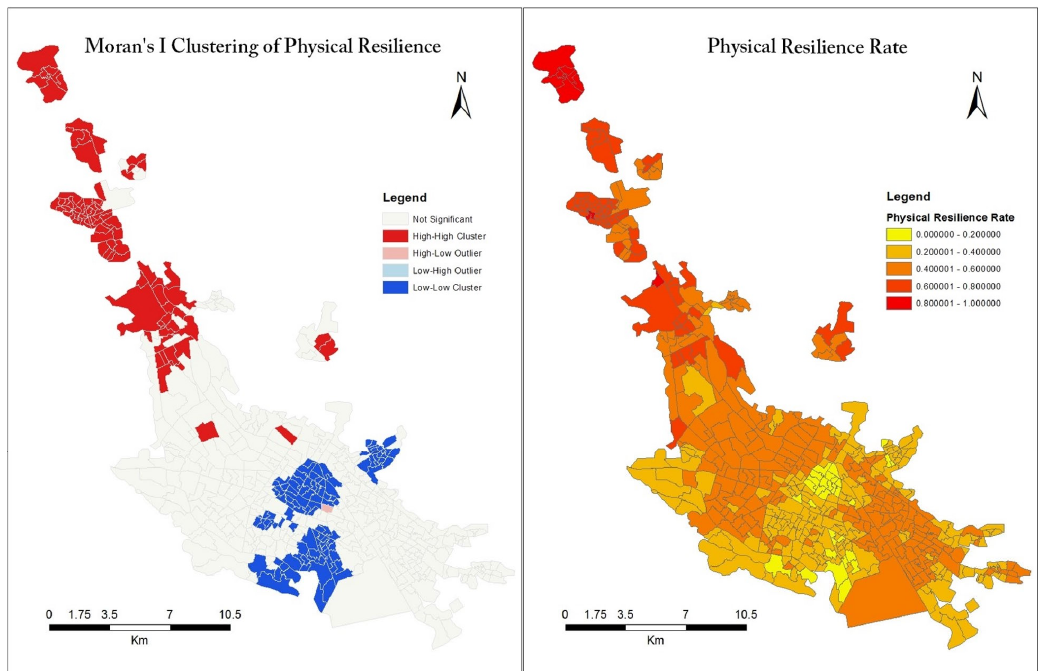
Figure 6. Physical urban resilience value distribution in the case of Shiraz.